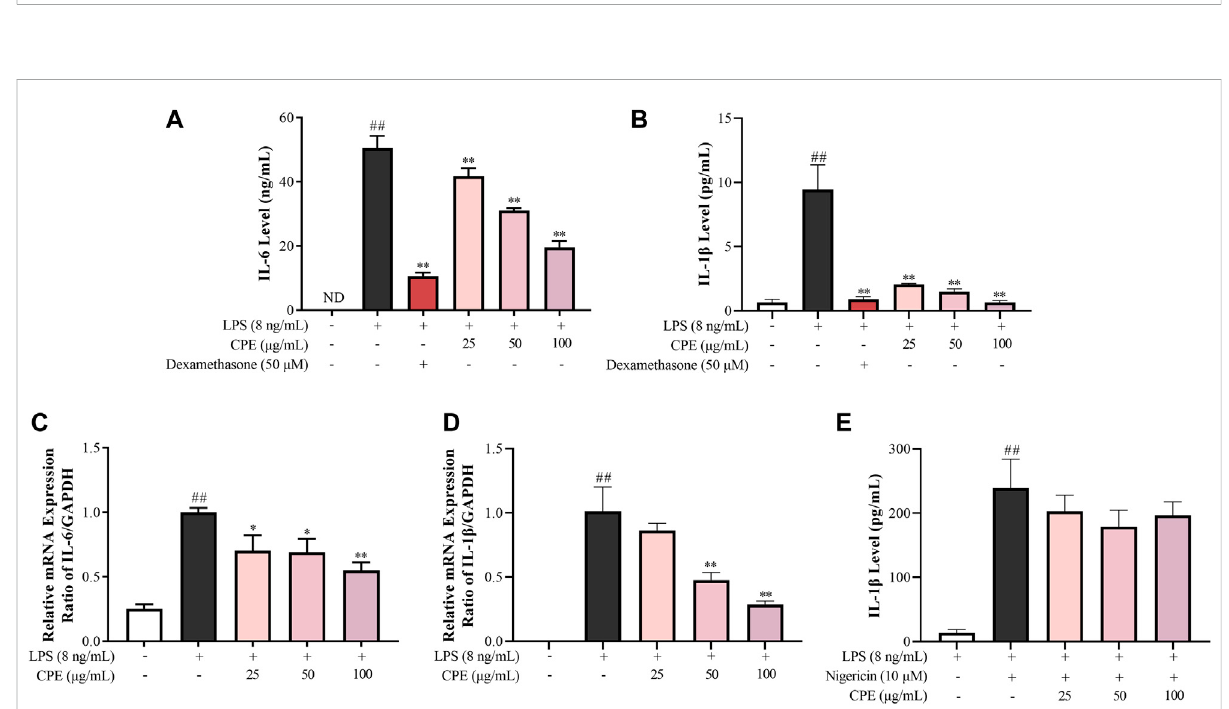
FIGURE 7 Effects of CPE on IL-6 and IL-1 β productionin LPS-stimulated RAW264.7macrophages ( n = 3). (A,B) Effects of CPE on supernatant IL-6 (A) and IL-1 β (B) in LPS-stimulated RAW264.7 macrophages. The cells were treated with LPS (8 ng/ml) with or without CPE for 24 h. IL-6 and IL-1 β levels in thesupernatantwerethendetectedbyELISA.Dexamethasonewasusedasapositivecontrol. (C,D) EffectsofCPEonthemRNAlevelsofIL-6 (C) and IL-1 β (D) in LPS-stimulated RAW264.7 macrophages. The cells were exposed to LPS (8 ng/ml) and incubated with or without designated concentrations of CPE for 4 h. Total RNA was then extracted and reverse transcribed, and the mRNA expressions of IL-6 and IL-1 β were determined by RT-qPCR. (E) Effect of CPE on NLRP3 in fl ammasome activity in BMDMs. BMDMs were primed with LPS (8 ng/ml) for 12 h and then treated with different concentrations of CPE for 30 min. Then, the cells were treated with nigericin (10 µM) for further 45 min to activate NLRP3 in fl ammasome. Supernatant IL-1 β level was detected by ELISA. ## p < 0.01 vs. normal control group; * p < 0.05 and ** p < 0.01 vs. LPS alone group. ND, not